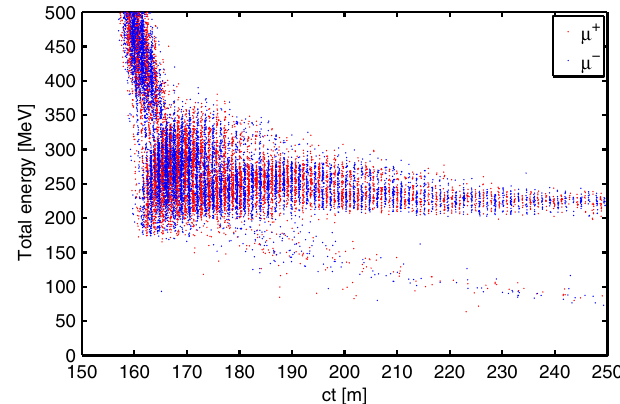
FIG. 5. Distribution of particles in longitudinal phase space at the phase rotation end. (cid:1) þ are shown in red and (cid:1) (cid:2) are shown in